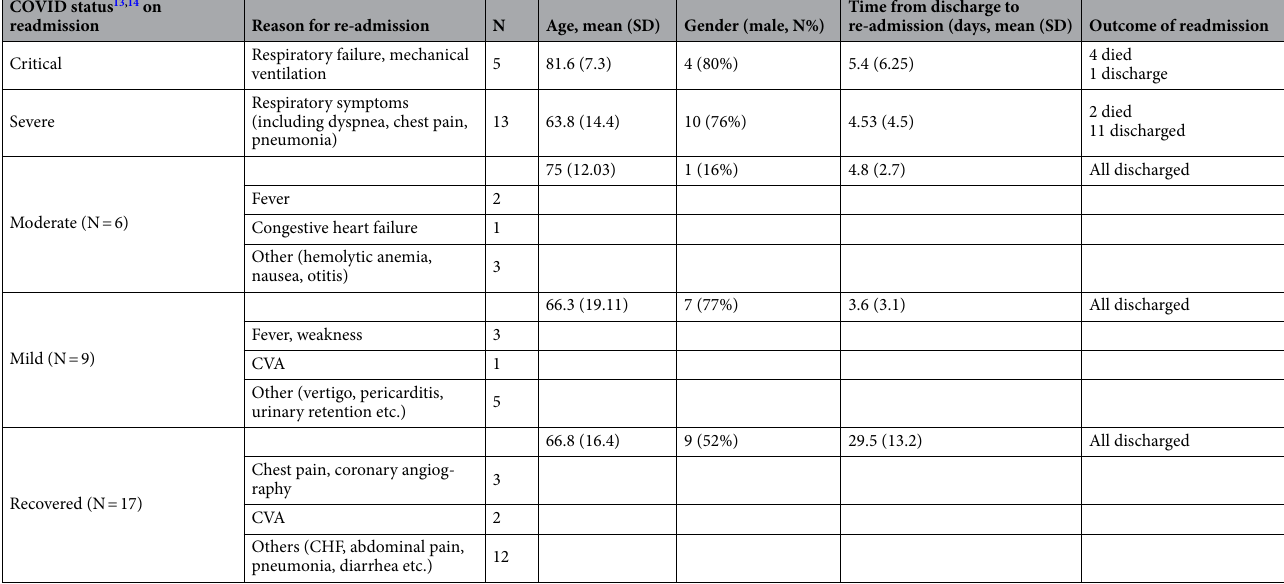
Table 2. Clinical characteristics of re-admitted